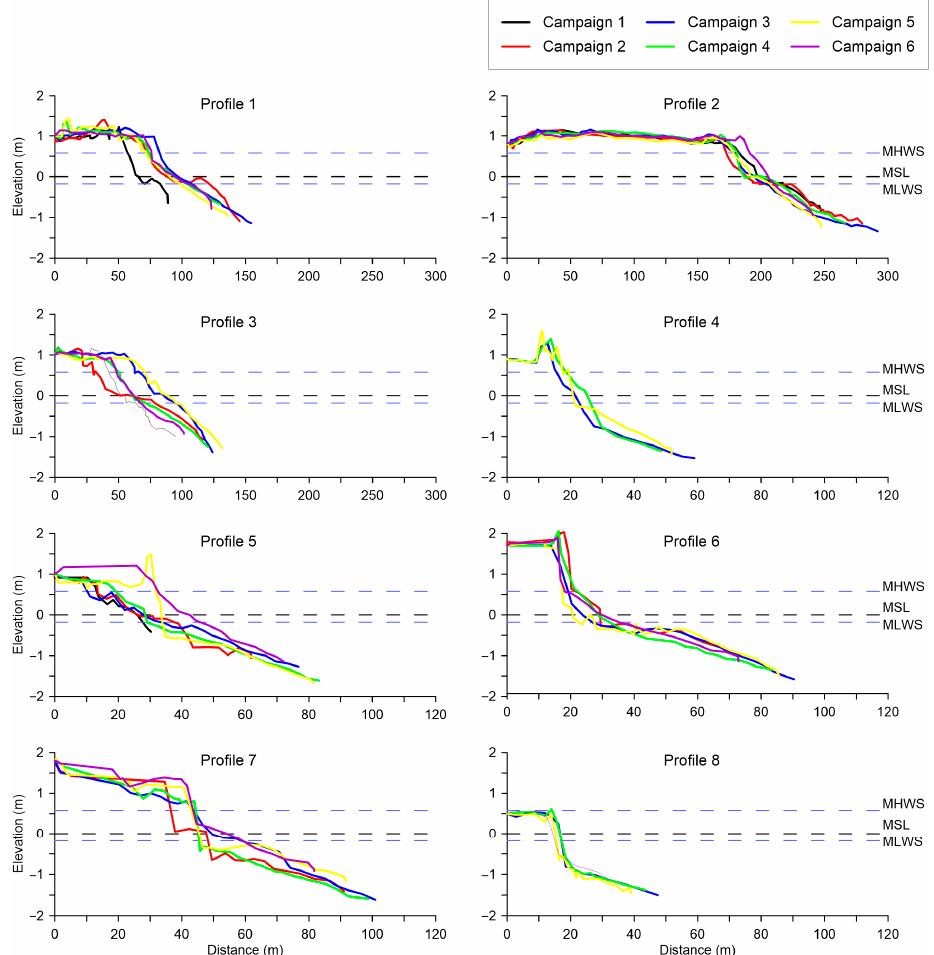
Figure A1. Beach profiles measured the coloured lines show the measurements from each campaign. High Tide Maximum Live Equinox (PMVE), Mean Sea Level (NMM), and Low Tide Minimum Live Equinox (BMVE) are shown for reference.